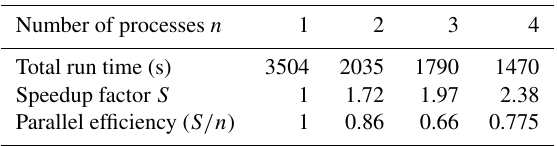
Table 5. Run time and speedup using up to four cores on a ThinkPad P52s laptop (900000